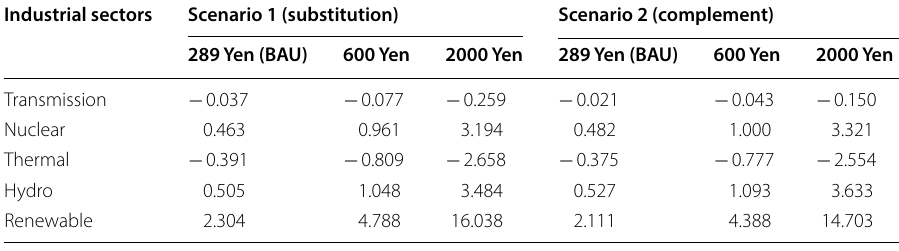
Table 6 Change rate (%) of electricity generation Industrial sectors